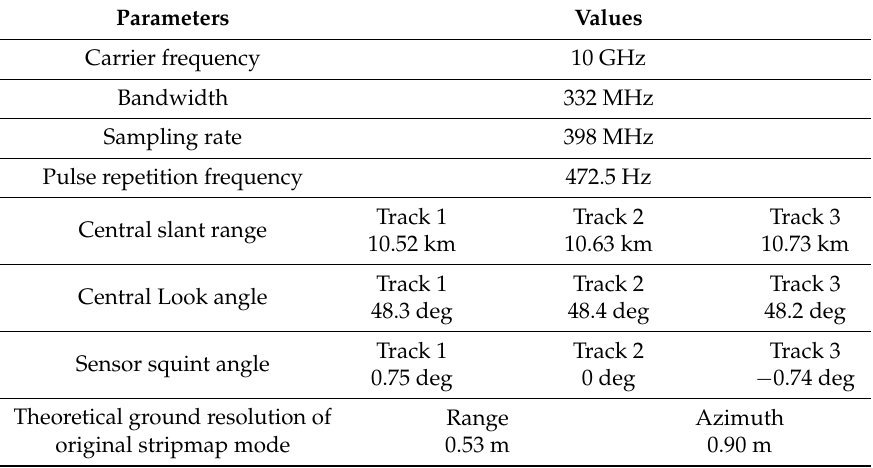
Figure 9. Gazing angle sequence of the stitched data. Table 1. Main simulation parameters.